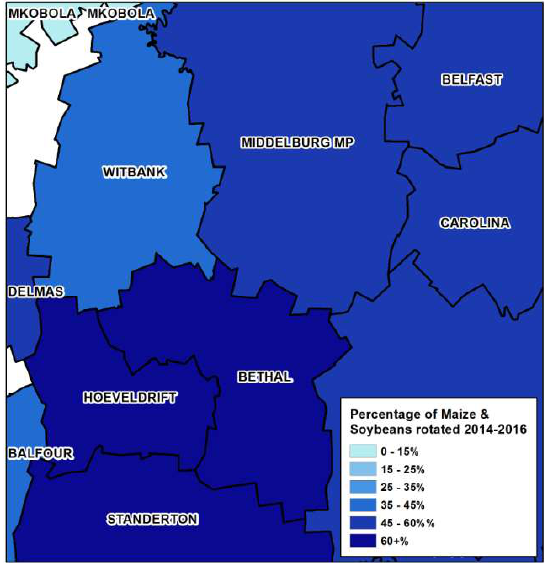
Figure 23. The percentage of the area of maize and soybeans which were rotated between 2014 and 2016 It is clear that certain districts have a larger total area of crop rotation and a larger percentage area of crop rotation than other districts. Viewing Bethal and Middelburg in the Figure 22 above one can see that they have a similar amount of area being